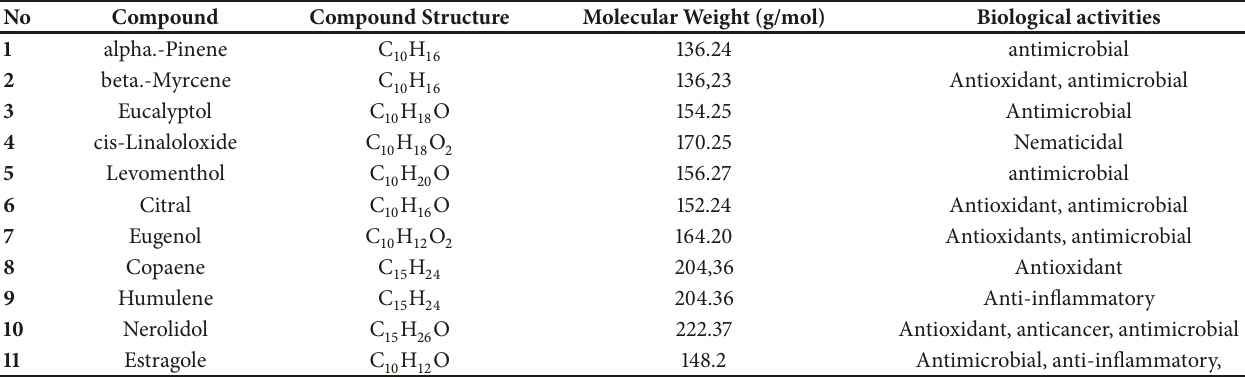
Table 2: Bioactivity of phytocomponents identified in the essential oil of Sweet basil by GC-MS.